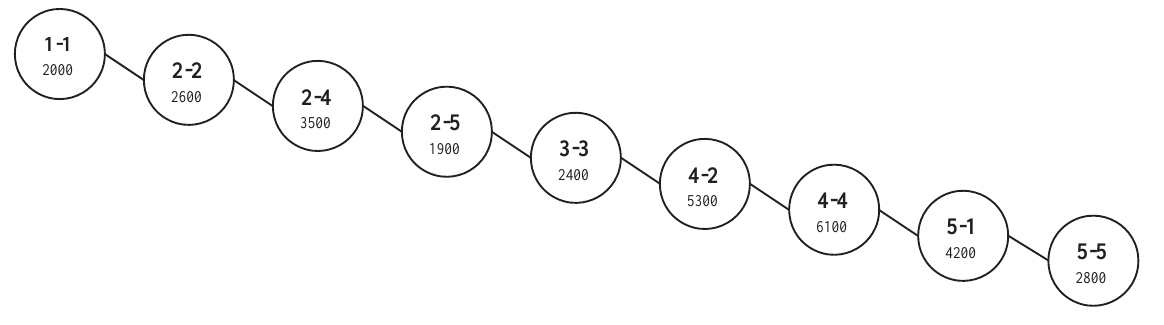
Figure 4. Binary search tree corresponding to the matrix of Figure